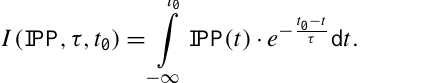
of 45 km (bottom) and 56 km (top). The colour code of the crosses is time dependent: at days before the SPE the crosses are green and yellow. During the SPE they are orange and merge to red till the end of December. Days in 2004 are dark (black to